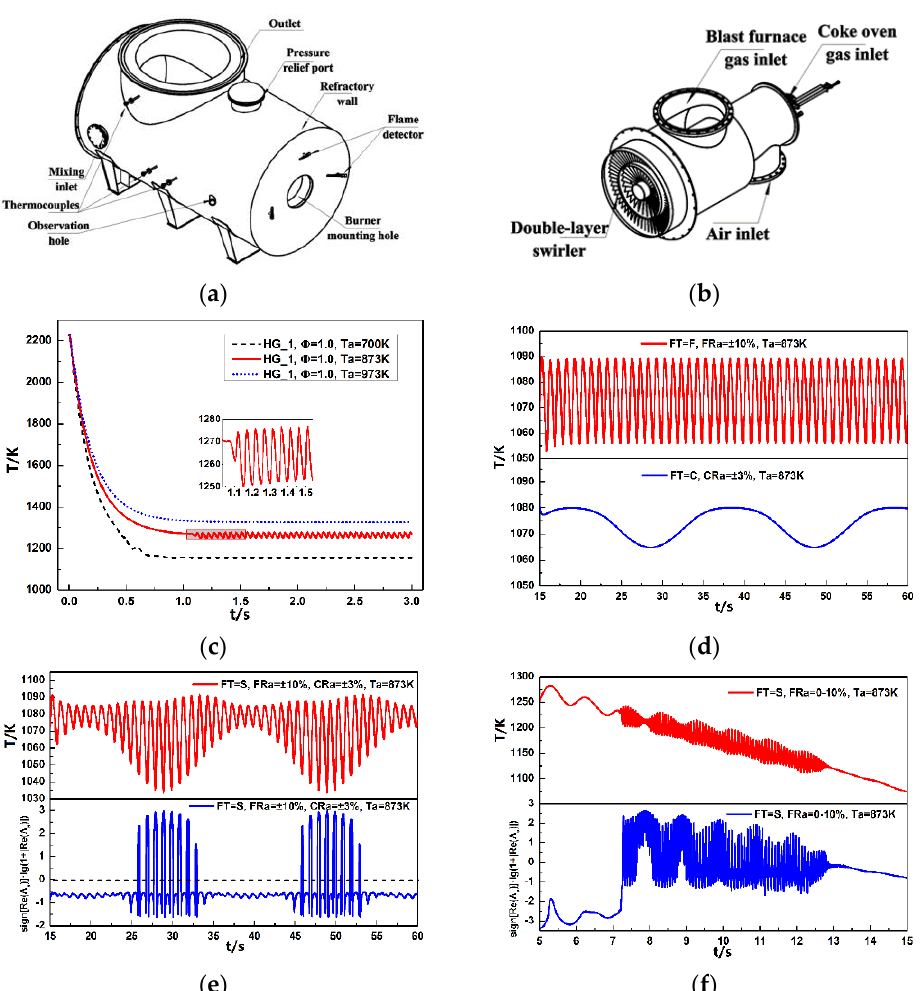
Figure 3. LCIG oscillating combustion in the Shiheng steel plant of China. ( a ) hot air heater body; ( b ) LCIG burner; ( c ) first type oscillation; ( d ) second type oscillation; ( e ) third type oscillation; ( f ) fourth type oscillation. Reprinted from Ref. [48].